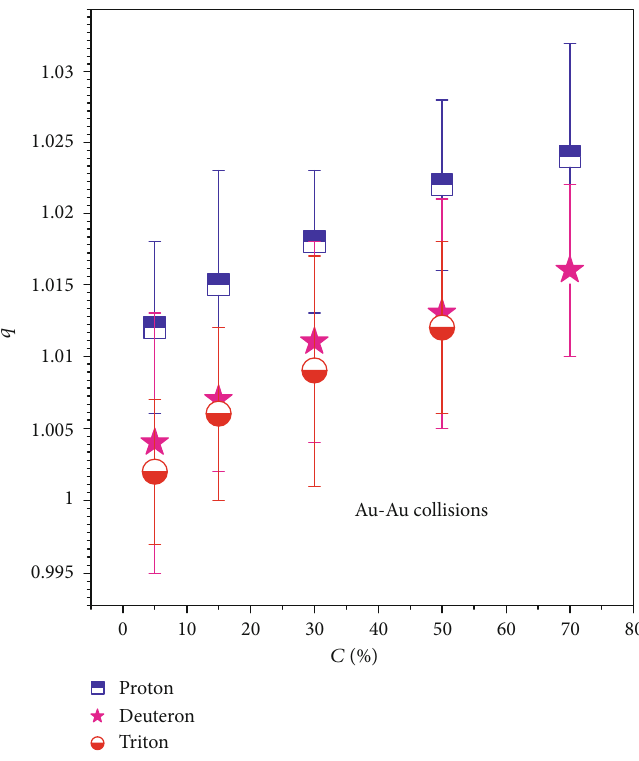
Figure 7: Dependence of q on